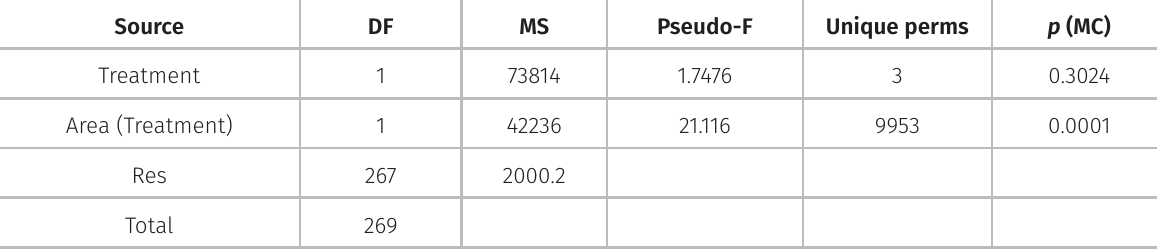
Table I. Asymmetrical PERMANOVA based on the Bray–Curtis dissimilarities (untransformed data) of the benthic assemblages.